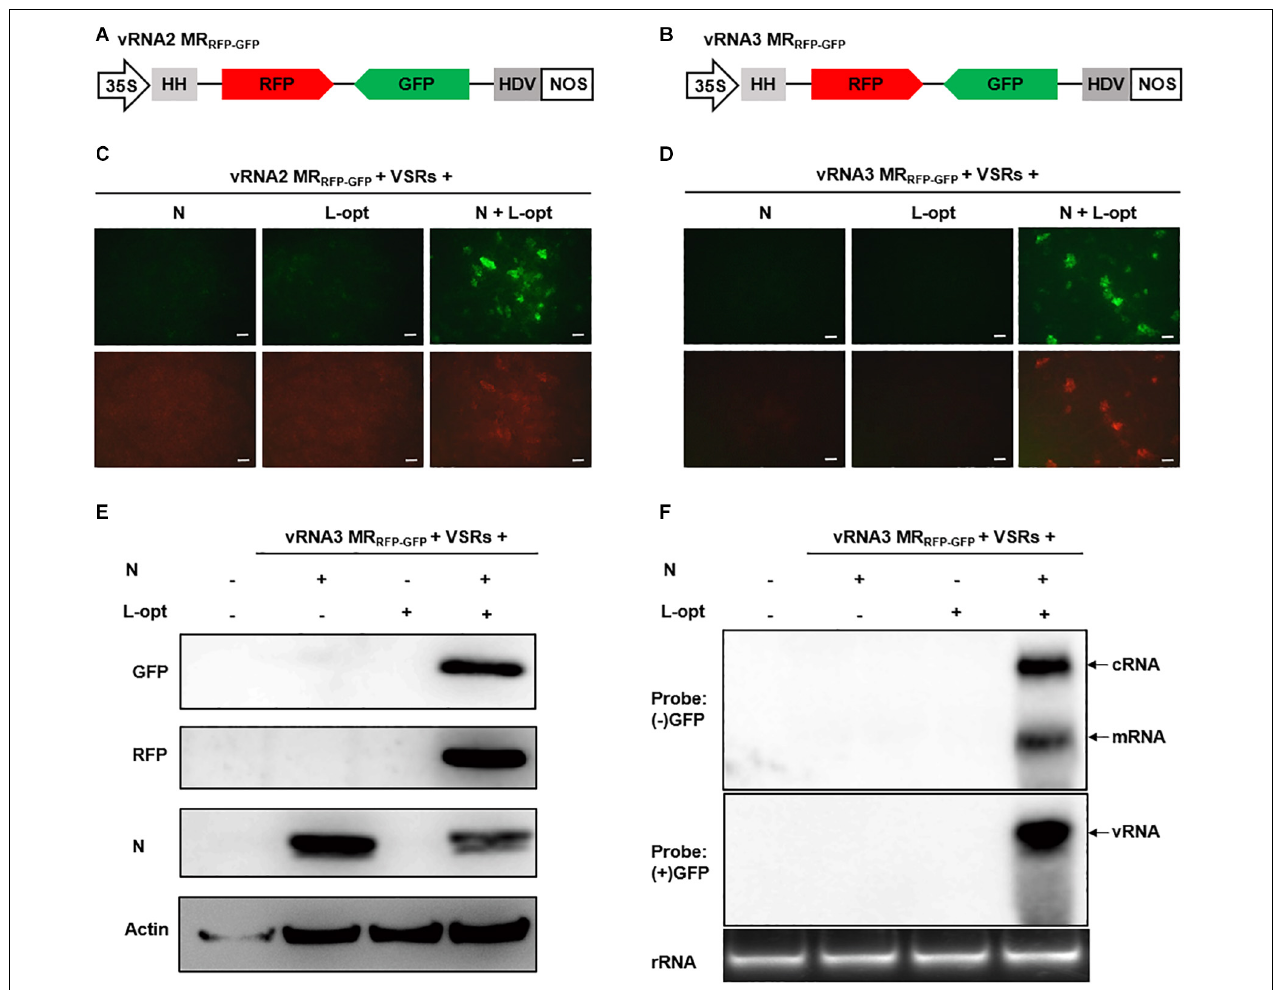
FIGURE 2 | Development of rice stripe virus (RSV) vRNA2- and vRNA3-based MR systems. (A, B) Schematic representation of the constructs used for transcription of (A) vRNA2 MR RFP - GFP and (B) vRNA3 MR RFP - GFP . The virion- and complementary-strand viral open reading frames (ORFs) in RNA2 and RNA3 were replaced with red fluorescent protein (RFP) and green fluorescent protein (GFP), respectively. (C, D) Visualization of GFP and RFP expression from (C) vRNA2 MR RFP - GFP and (D) vRNA3 MR RFP - GFP supported by N, L-opt, or N plus L-opt. Agroinfiltrated leaves were photographed with a fluorescence microscope at 8 dpi. Scale bar = 200 µ m. (E) Western blot analyses of the expression of the GFP, RFP, and N proteins in agroinfiltrated leaf tissue shown in (D) . The blot was probed with a monoclonal antibody against N. benthamiana Actin protein to serve as a protein loading control. (F) Northern blot detection of the virion-sense (v)RNA, complementary-sense (c)RNA, and the subgenomic messenger (m)RNA derived from vRNA3 MR RFP - GFP replication and transcription with sense (+) and antisense ( − ) GFP